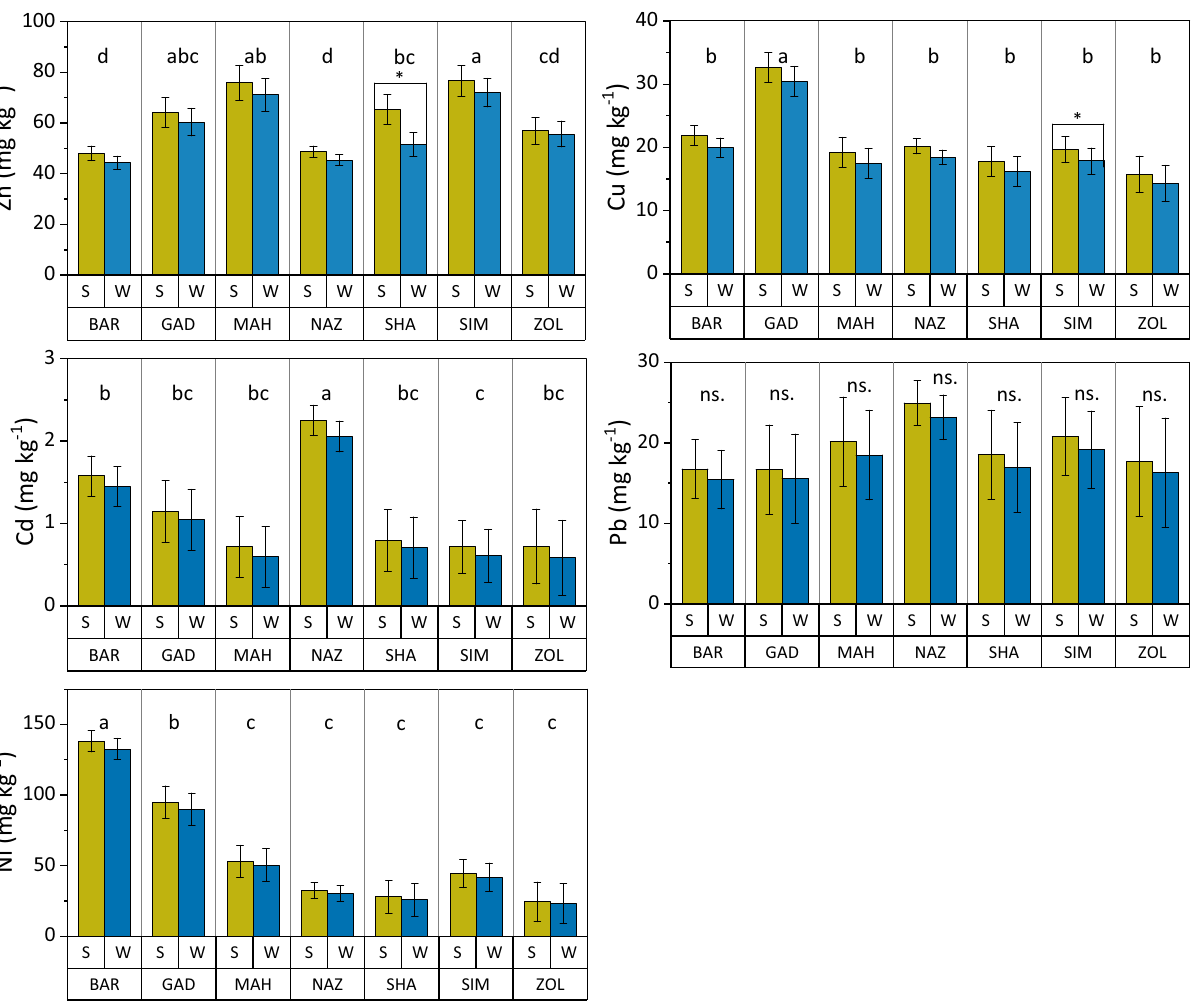
Figure 2. The comparison of the mean concentration of Zn, Cu, Cd, Pb, and Ni elements in the study rivers’ sediments during summer and winter. Different letters show significant differences in metal content among rivers pooled over seasons at P < 0.05 confidence level. ns. represents the lack of significat difference.